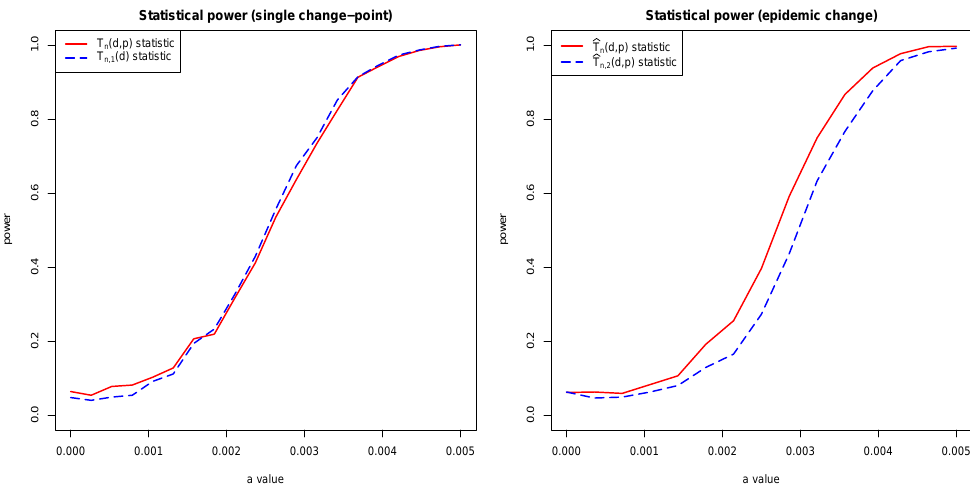
Figure 10. Power